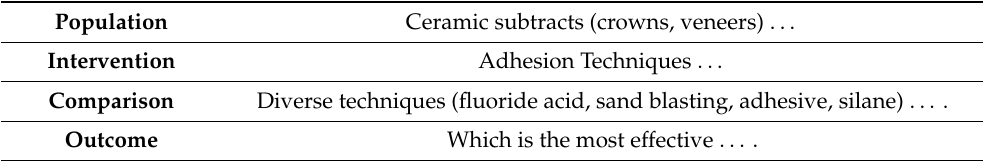
Table 1. The PICO question. Population Ceramic subtracts (crowns, veneers) . . . Intervention Adhesion Techniques . .